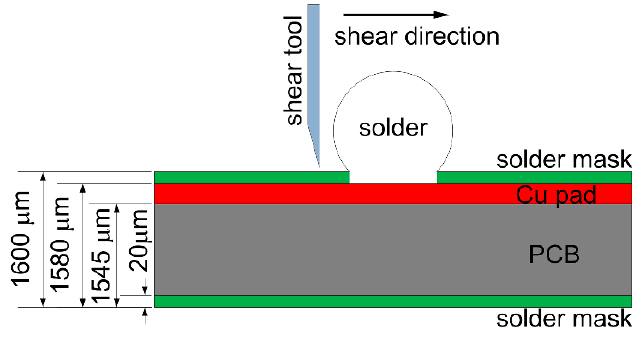
Figure 2. Schematic diagram on the ball shear test.